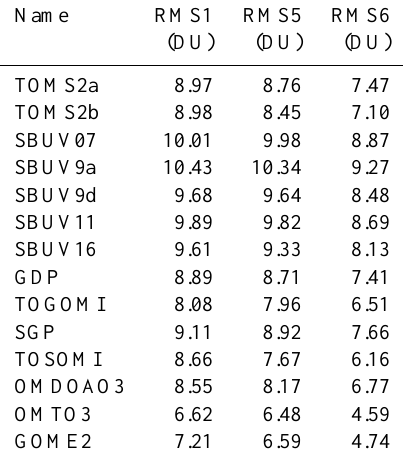
Table 4. Noise in the satellite dataset with respect to the ground network. RMS1 is before and RMS5 is after the corrections have been applied. RMS6 is the estimate of the noise in the satellite dataset